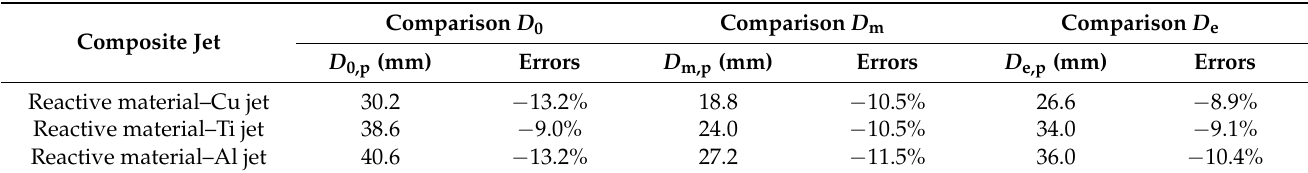
Table 6. Comparison between numerical penetration hole diameters and experimental results.